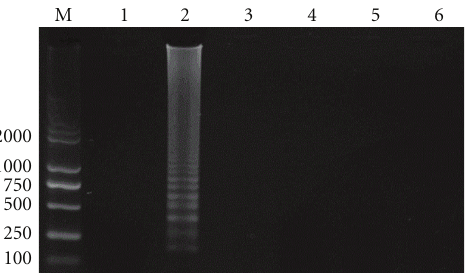
Figure 3: Specificity of LAMP. M: DL2000 DNA marker; 1: negative control; 2: Staphylococcus aureus ; 3: Escherichia coli ; 4: Streptococcus agalactiae ; 5: Salmonella typhimurium ; 6: Staphylococcus epider- midis